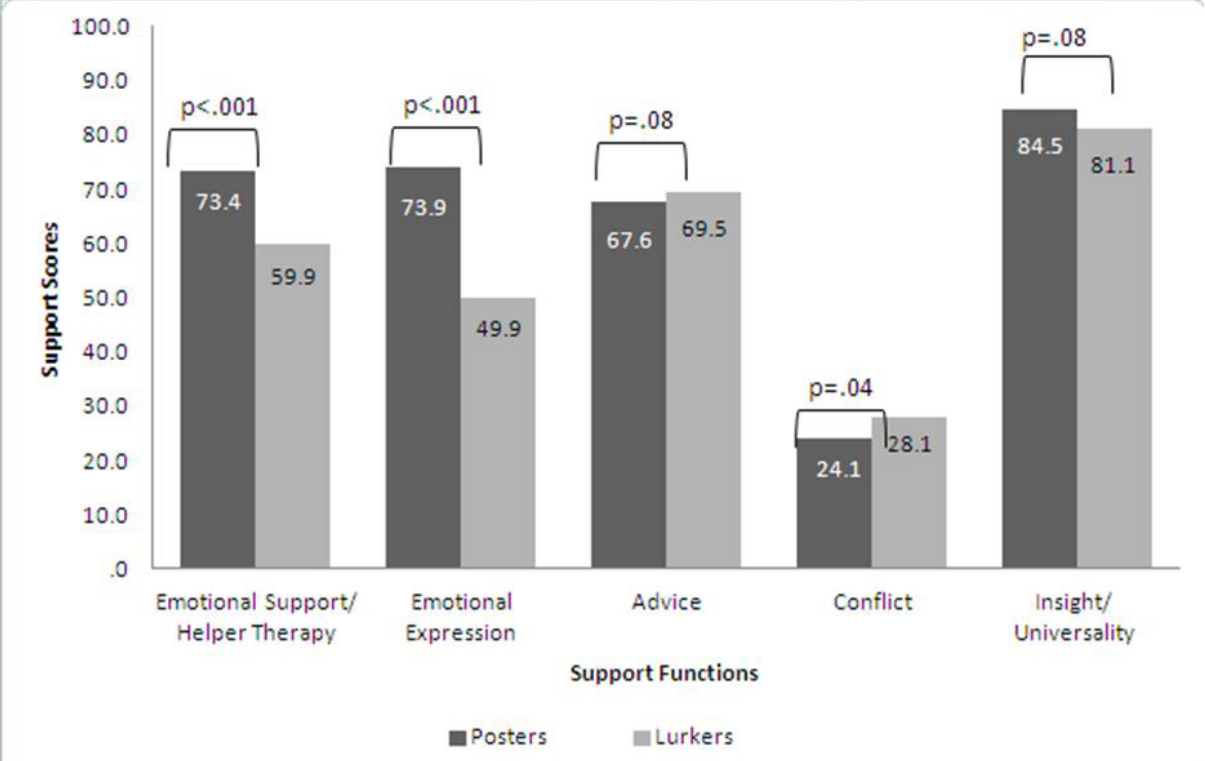
Figure 1. Support scores for posters and lurkers.